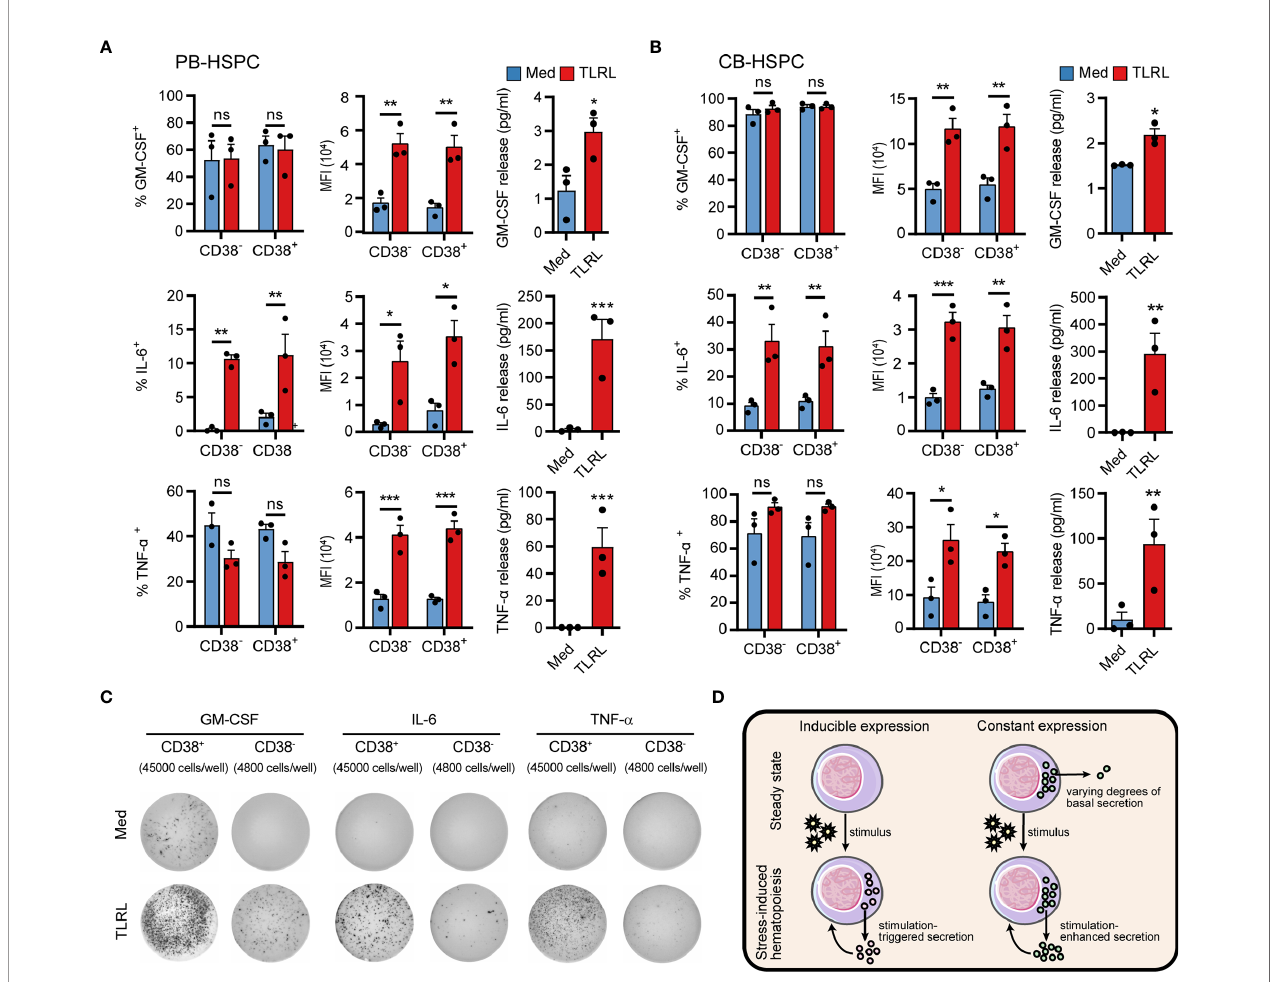
FIGURE 6 | Cytokine production and secretion by PB- or CB-derived HSPCs. (A, B) Adult PB- (A) or neonatal CB-derived (B) CD34 + HSPCs were either left untreated or stimulated with LPS and Pam3CSK4 for 12 h. The percentages of cell expressing GM-CSF, IL-6 and TNF- a were determined by fl ow cytometry. MFI of the cytokine signals in the corresponding positive cells are shown. The secretion of cytokines in the supernatant was quanti fi ed by ELISA, with 20,000 CD34 + cells in 200 µl medium. Data are shown as the mean ± SEM. * P < 0.05, ** P < 0.01, and *** P < 0.001; ns, not signi fi cant, by 2-way ANOVA followed by Bonferroni ’ s test or Student ’ s t test. (C) The number of cytokine-expressing HSPCs were measured by ELISPOT. CD34 + CD38 - cells (4,800 cells/well) or CD34 + CD38 - cells (45,000 cells/well) were incubated for 20 h in ELISPOT plates in the presence or absence of LPS and Pam3CSK4. The data refer to a typical experiment out of three that generated similar results. (D) Summary of two different regulatory modes of cytokine production in